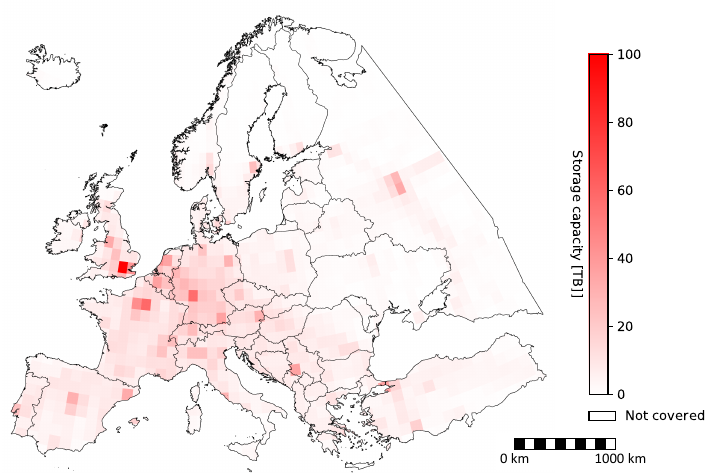
Figure 20. Storage required for storing aerial images taken from all flights with Imperx T9040.